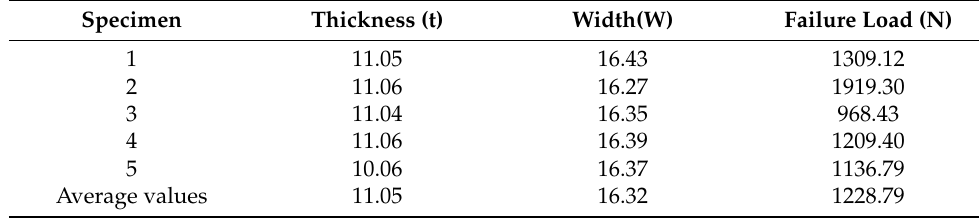
Figure 4. Through-thickness sample during testing in the tensile machine.